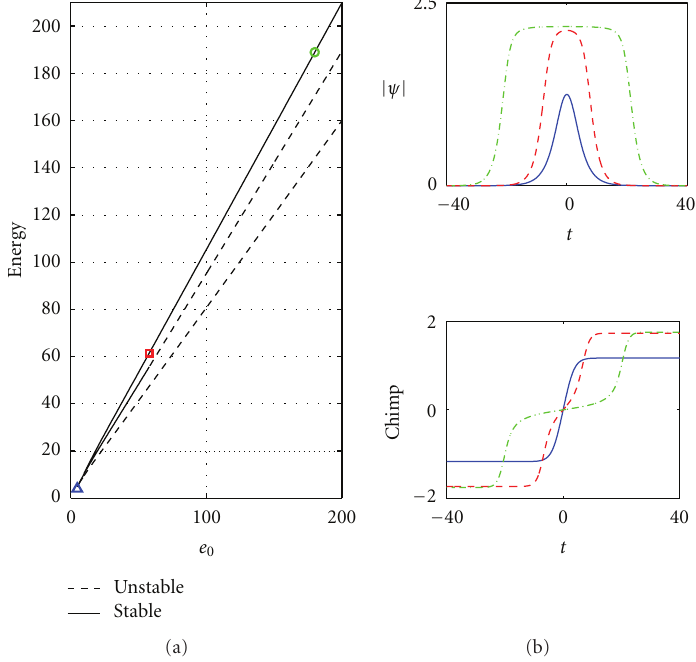
Figure 5: DSR in the case of saturating gain. (a) Pulse energy (cid:6) ψ (cid:6) 2 as a function of e 0 at D = − 1 . 6 (top), D = − 1 . 2 (middle), and D = − 0 . 8 (bottom), respectively. The rest of the parameters are g 0 = 2 . 3991, τ = 0 . 1667, α 1 = 0 . 7863 π , α 2 = 0 . 3 π , α 3 = α p = 0, K = 0 . 1, and Γ = 0 . 1. (b) The corresponding pulse shape (top) and frequency chirp profile (bottom) at e 0 = 5 (blue solid curves), e 0 = 58 (red dashed curves), and e 0 = 180 (green dash-dot curves) along the D = − 1 . 6 line, respectively (from